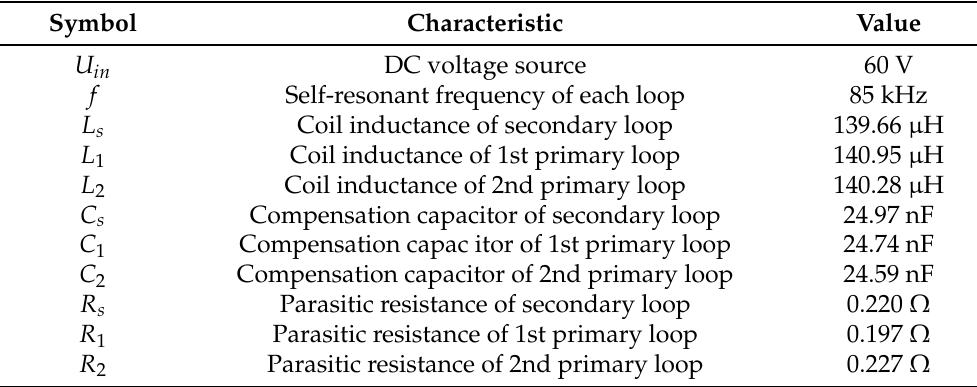
Table 2. Two-to-one WPT system prototype